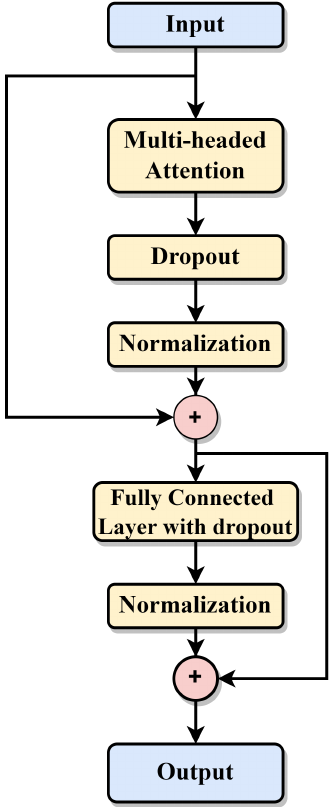
Figure 3. Block diagram of transformer encoder for the proposed